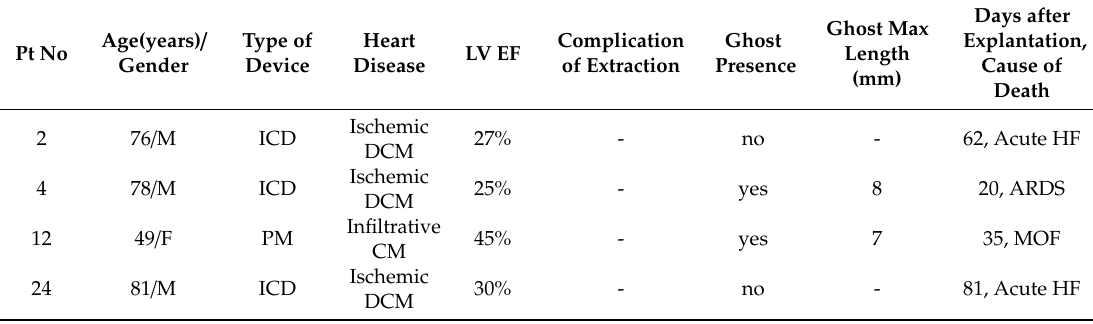
Table 4. Main features in patients who died.